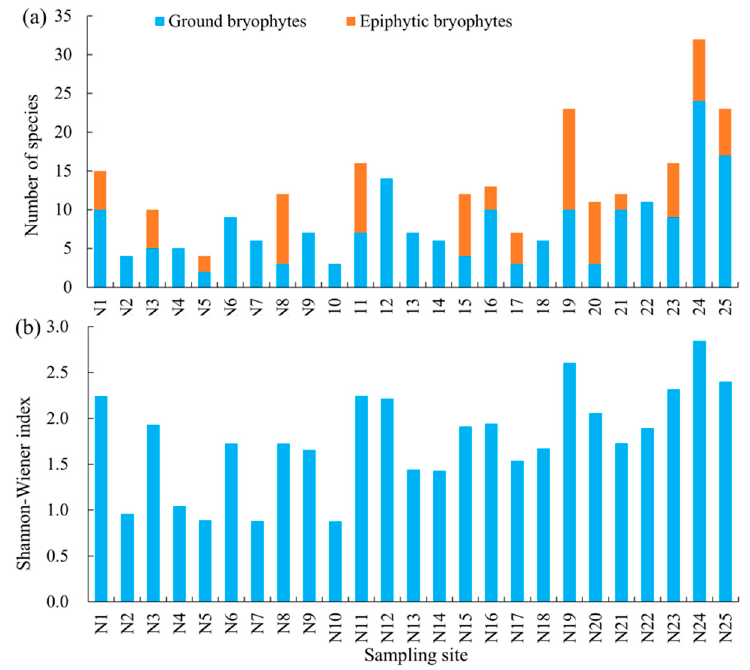
Figure 2. Bryophyte diversity of 25 sampling sites in urban areas of Wuhan: ( a ) number of species surveyed that grow on the ground or tree trunks and ( b ) α diversity index.